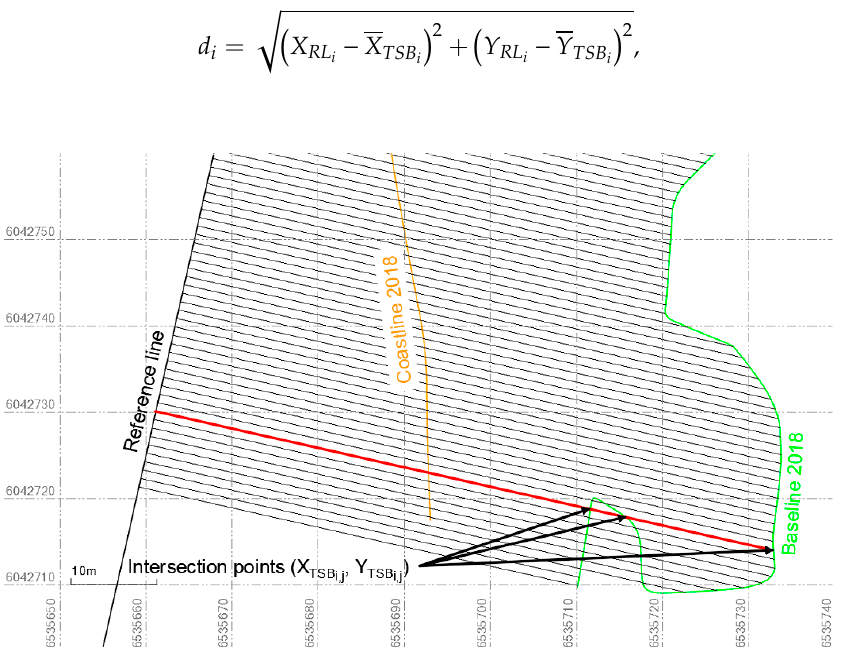
Figure 8. A specific case, in which the line perpendicular to the reference line intersects the baseline at more than one point.